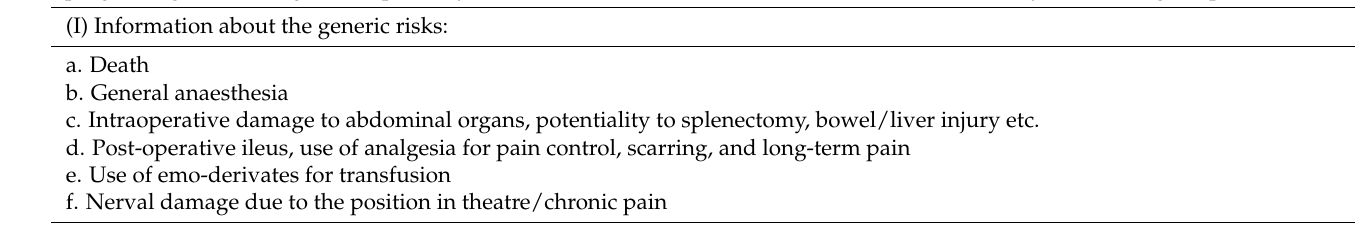
Table 2. Summary of key points to be discussed when counselling a potential living kidney